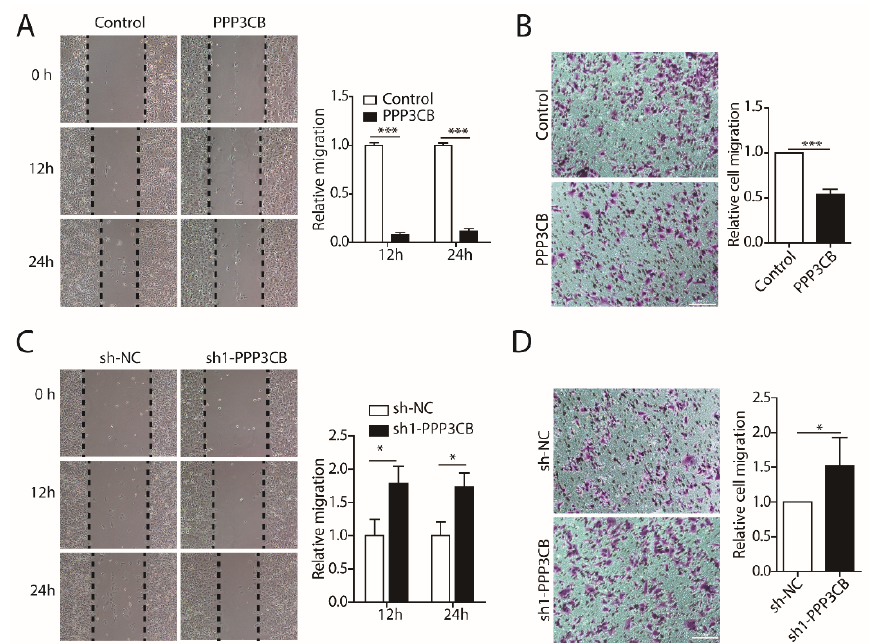
Figure 3. PPP3CB inhibits cell migration. ( A , C ) G401 stable cells with overexpression or knockdown of PPP3CB were assessed for cell migration by wound healing at the indicated time points (0 h, 12 h, and 24 h). Data were presented as mean ± SEM from three independent experiments. * p < 0.05, ** p < 0.01, and *** p < 0.001 ( B , D ) Transwell assays were used to assess cell migration. The scale bar is 100 µ m. Data were presented as mean ± SEM from three independent experiments. * p < 0.05, ** p < 0.01, and *** p < 0.001.